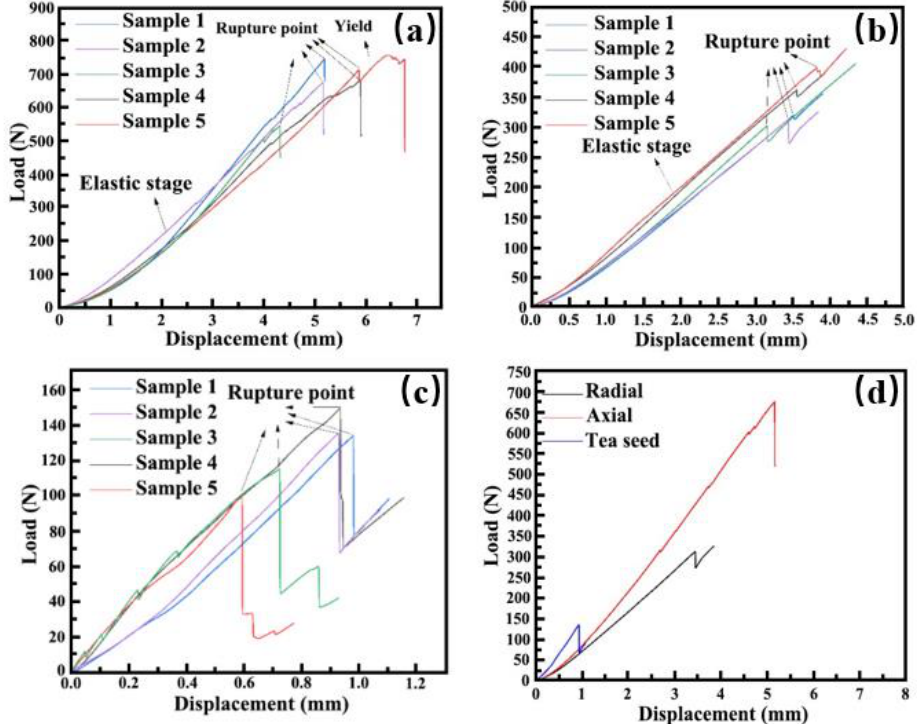
Figure 8. Load-displacement curves of fresh Camellia oleifera fruit. ( a ) Axial compression load-displacement curve. ( b ) Radial compression load-displacement curve. ( c ) Compression load-displacement curve of tea seed. ( d ) Comparison of mechanical characteristic curves of different parts. Table 2. Mechanical properties of fresh Camellia oleifera